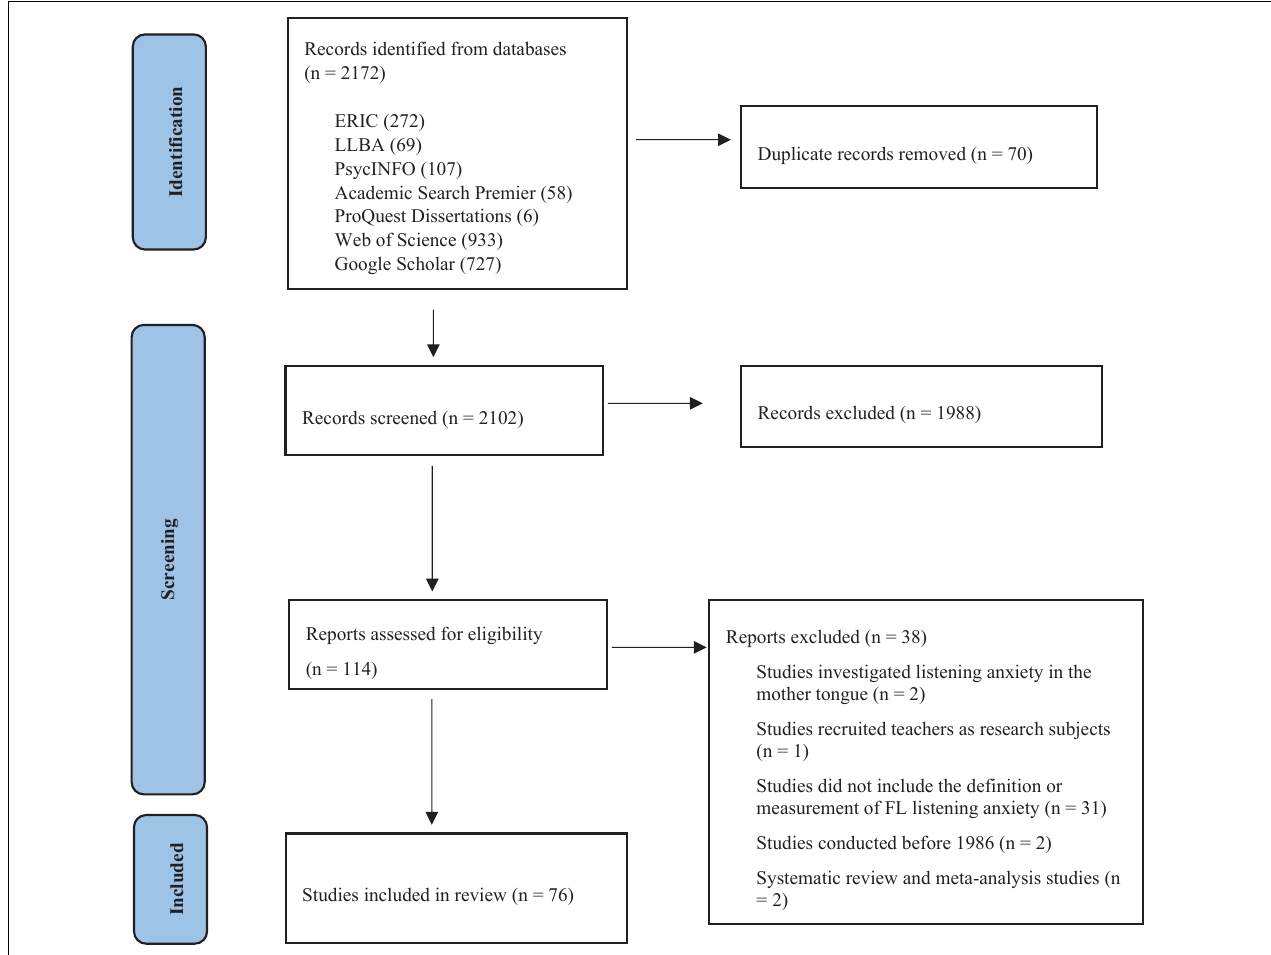
FIGURE 1 | PRISMA flowchart of study selection.